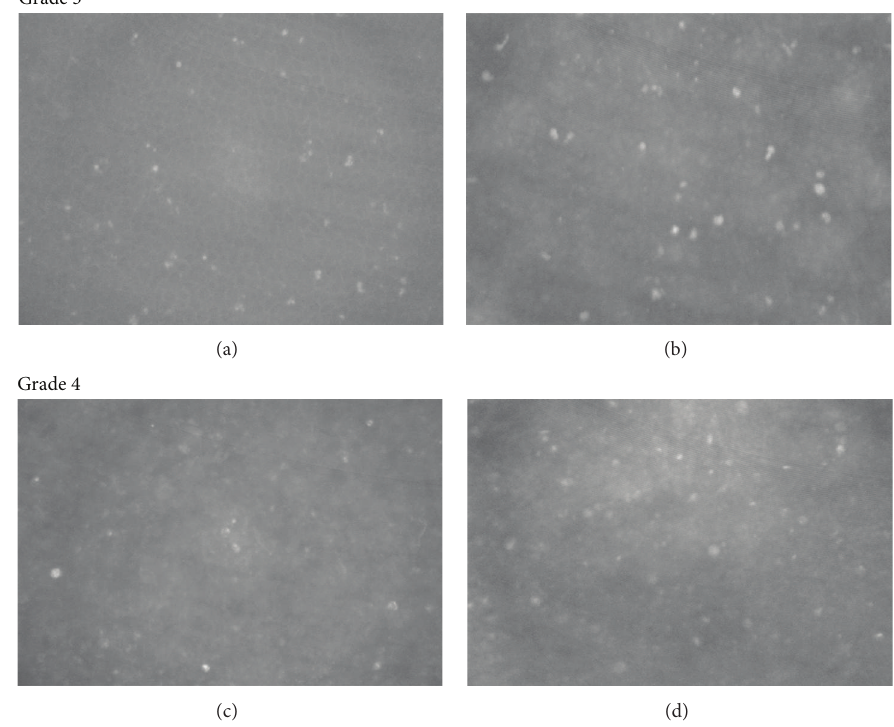
Figure 2: Severity grade 3 ((a) and (b)): numerous cysts, definite morphology, may or may not involve deeper corneal tissues, more densely concentrated. Severity grade 4 ((c) and (d)): numerous cysts and trophozoites, definite morphology, deeper corneal layers involved, densely concentrated, wide corneal area